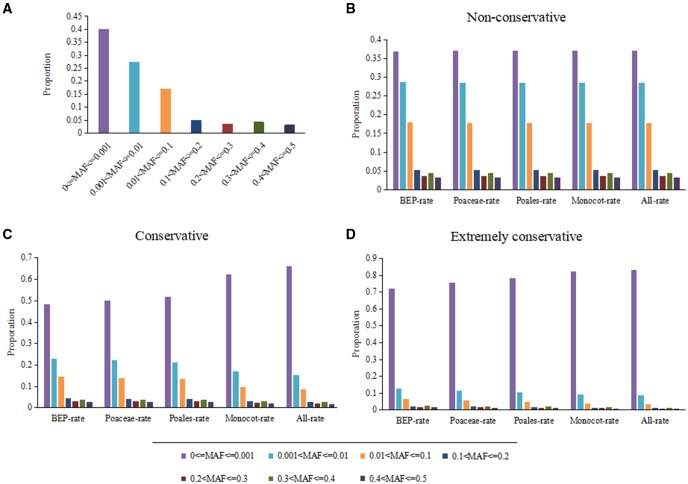
—Evidence of selection on conserved sites in the rice population. Minor allele frequency (MAF) distribution is shown at single polymorphic sites (SNPs) present in 3,000 rice genomes. When summarized at different clade level, they show similar levels of variation in different conserved categories, where the most conserved sites appear to be under the strongest selective pressure.